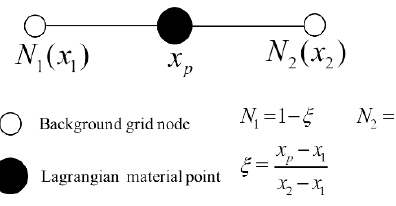
Figure 5. A shape function for connecting material point with background grid node s .